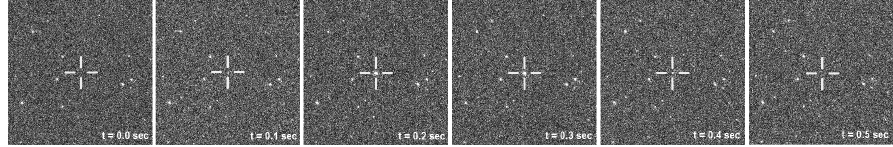
Fig. 9. A rapid optical flash detected by the MMT, with a duration less than 0.5 s and peak brightness reaching (cid:24) 6.5 mag. The flash coincides with a high-altitude passage of MOLNIYA satellite, according to the NORAD database (predicted distance is less than 400 ′′ , a typical error for satellite